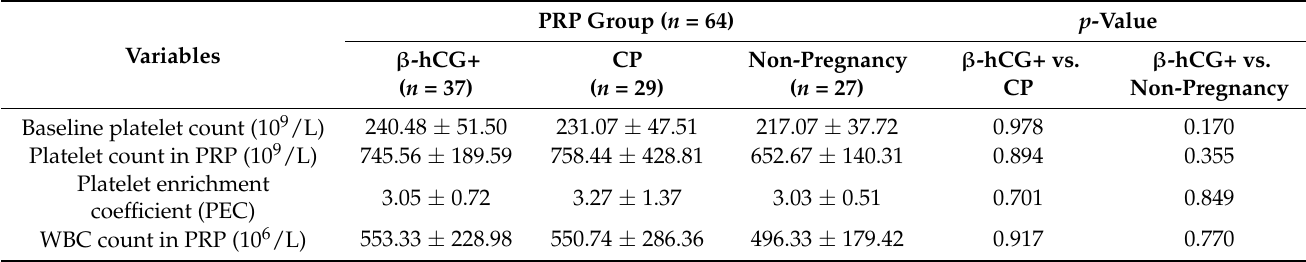
Table 5. Multiple comparisons to evaluate statistical differences in the PRP group.